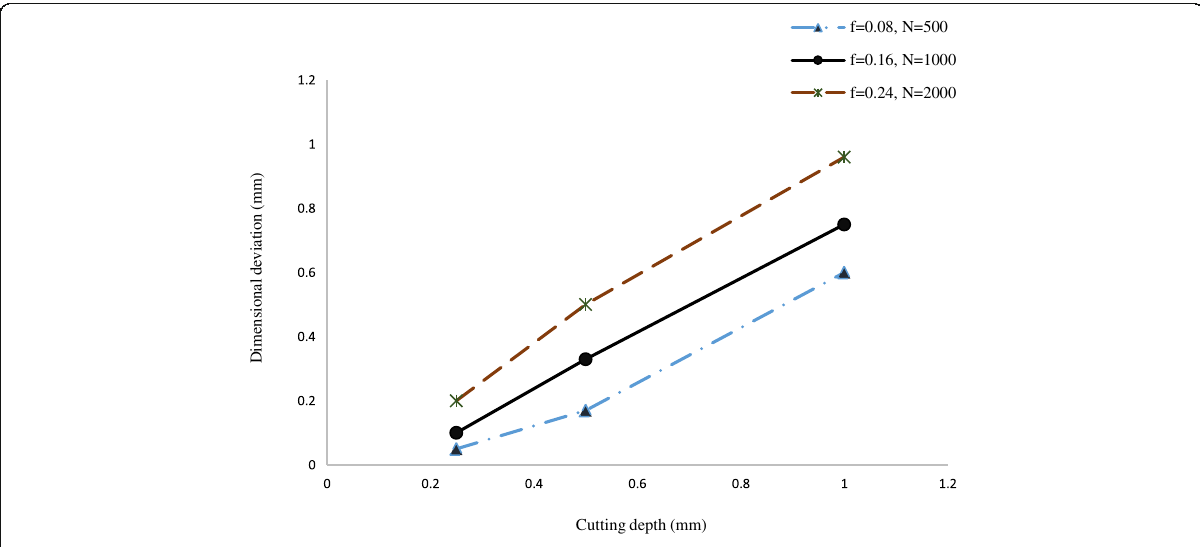
Fig. 8 The variations of the dimensional deviation at different depth of